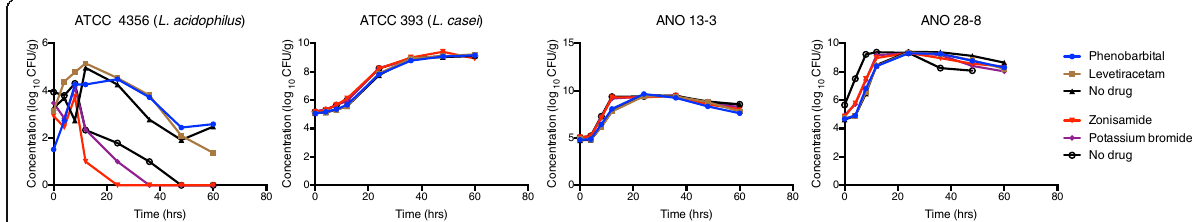
Fig. 3 Concentration of Lactobacillus over time while incubated with therapeutic concentrations of phenobarbital (20 μ g/mL), levetiracetam (20 μ g/ mL), zonisamide (20 μ g/mL), and potassium bromide (2.0mg/mL). Four strains of Lactobacillus were evaluated for each drug, two obtained from the ATCC (ATCC 4536, L. acidophilus and ATCC 393, L. casei ) and two anonymized samples obtained from dogs in the study (ANO-13-3 and ANO 28 –